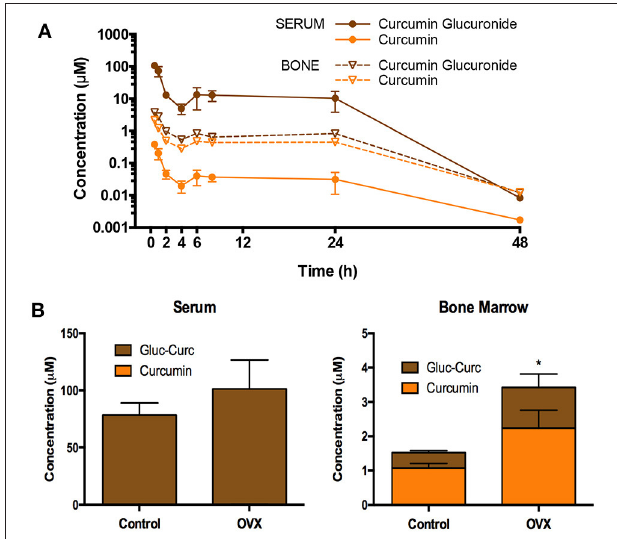
FIGURE 4 | Pharmacokinetics of oral curcuminoids in mice. (A) Circulating curcumin-glucuronide (CG) levels predominate and are sustained for up to 24h in mice following a single oral curcumin dose (HED 2.5g), with sustained, albeit lower, levels also documented in bone, where ß-glucuronidase-dependent GC hydrolysis to form aglycone curcumin occurs, resulting in higher aglycone concentrations than those perfusing bone. (B) Following curcumin ingestion in mature ovariectomized (OVX) mice modeling menopausal bone loss (vs. controls), the capacity of bone to deconjugate curcumin glucuronide distributing to this site persists and is higher in OVX mice. Interestingly, curcumin concentrations in mouse bones are also highest in trabecular bone compartments where menopausal bone loss is most pronounced. Figures are reproduced with permission from John Wiley and Sons